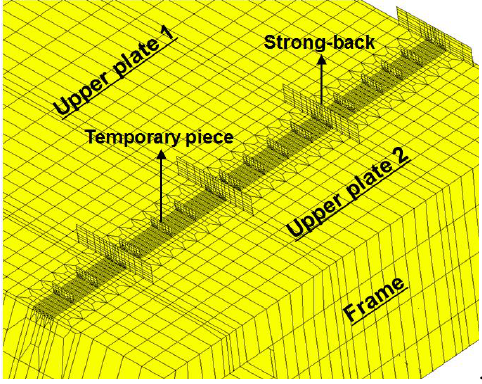
Figure 16. Finite elements model of panel block.